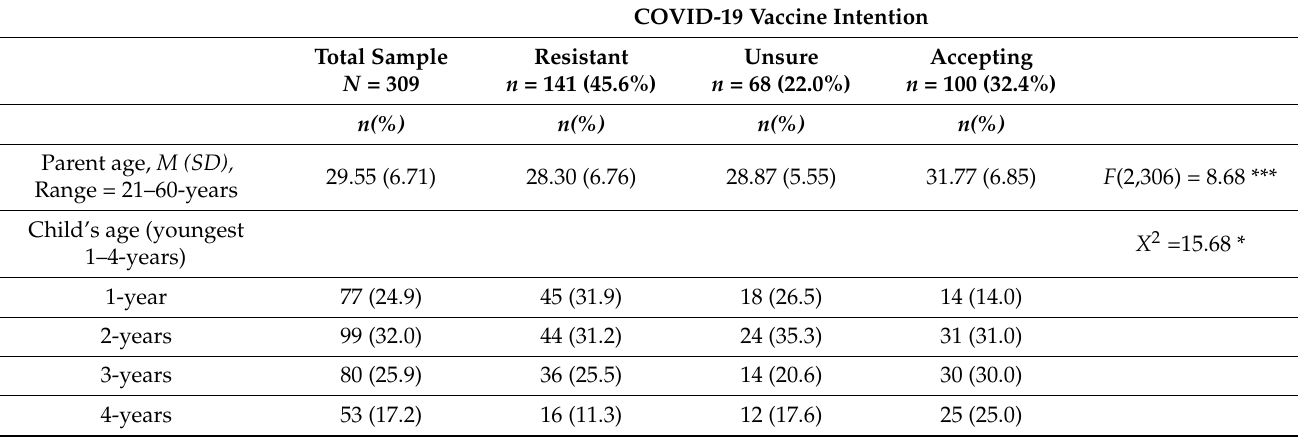
Table 1. Frequencies/percentages and means/standard deviations for parental demographic charac- teristics and non-parametric analyses across COVID-19 vaccine intent